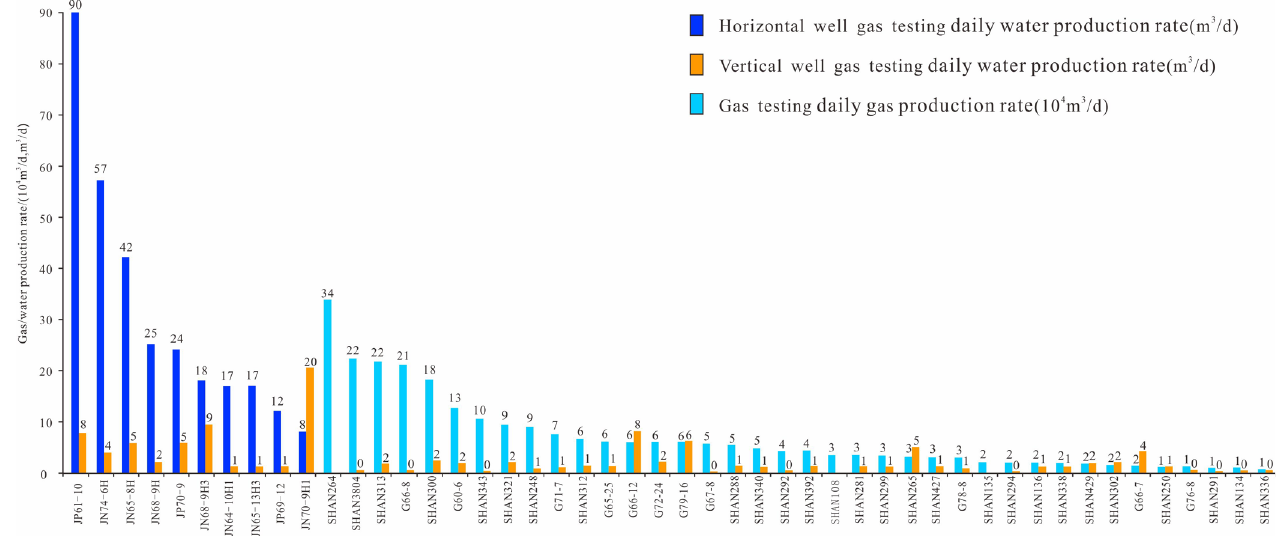
Figure 2. The distribution histogram of gas well testing production in Gaoqiao.